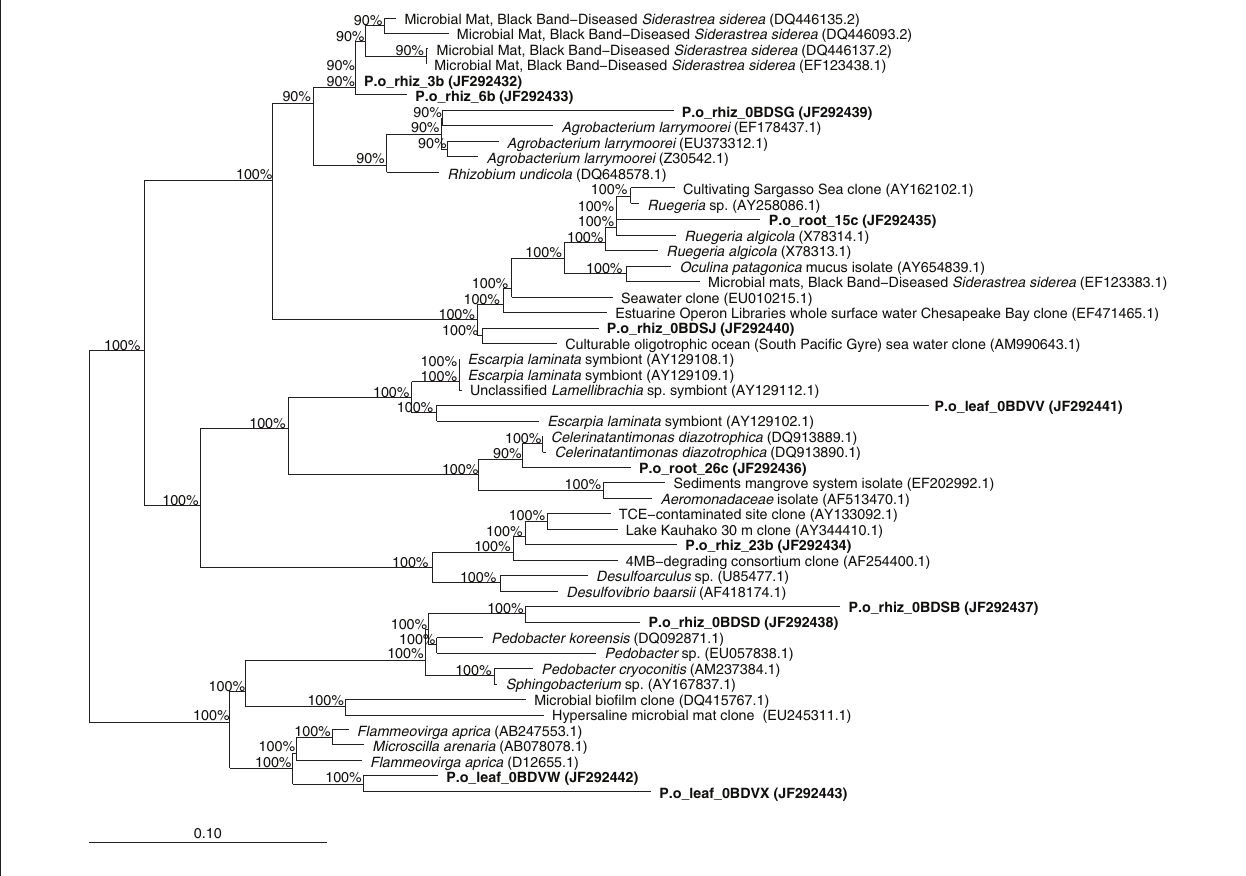
FIGURE 5 | Phylogenetic affiliation of the sequences obtained from the endophytic bacterial community of P. oceanica . Sequences obtained in this study are printed in bold. The values at each node represent the bootstrap values generated using the ARB parsimony interactive